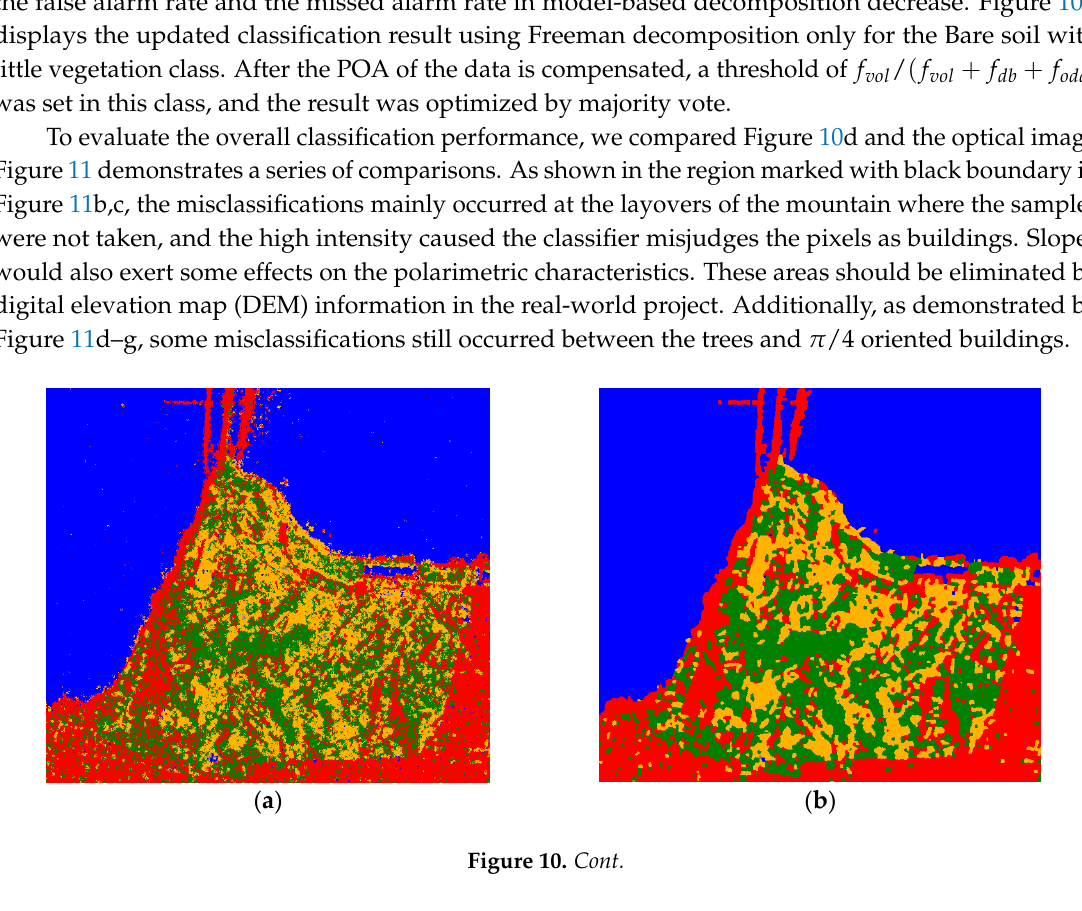
Table 3. Comparison of the running time and adjusting time between simple linear iterative clustering (SLIC) and the proposed method presented in Table 3. The cost time is based on the whole polarimetric SAR image with 4500 × 3000